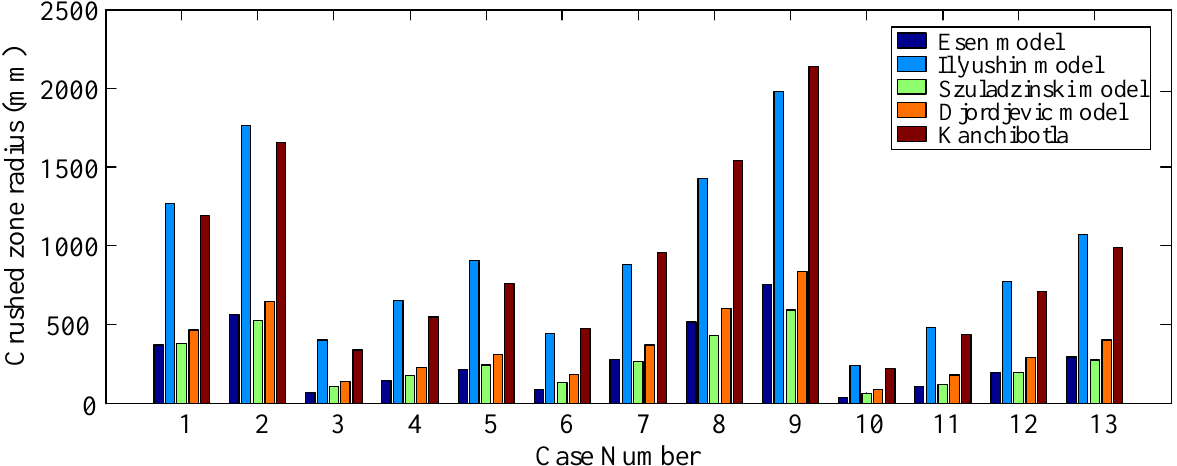
Figure 7. Comparison of different models in estimating damage radius obtained from the 13 studied